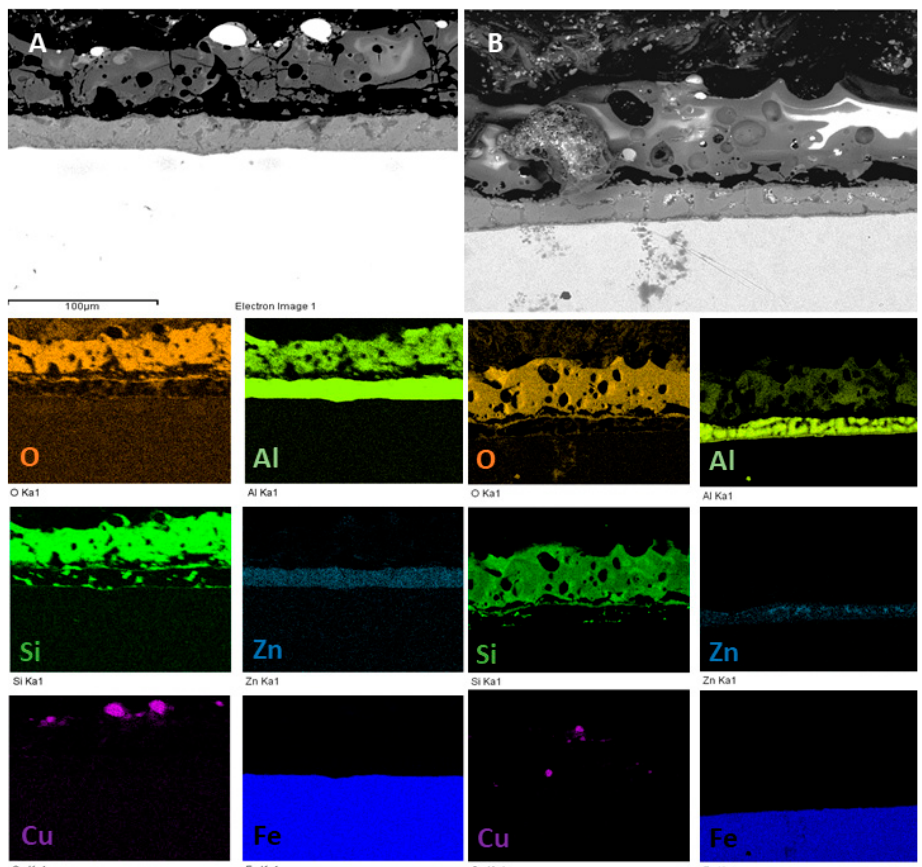
Figure 5. EDS elemental maps of the samples obtained working at 1 A/cm 2 in UPC with large particles ( A ) and with small particles ( B ).